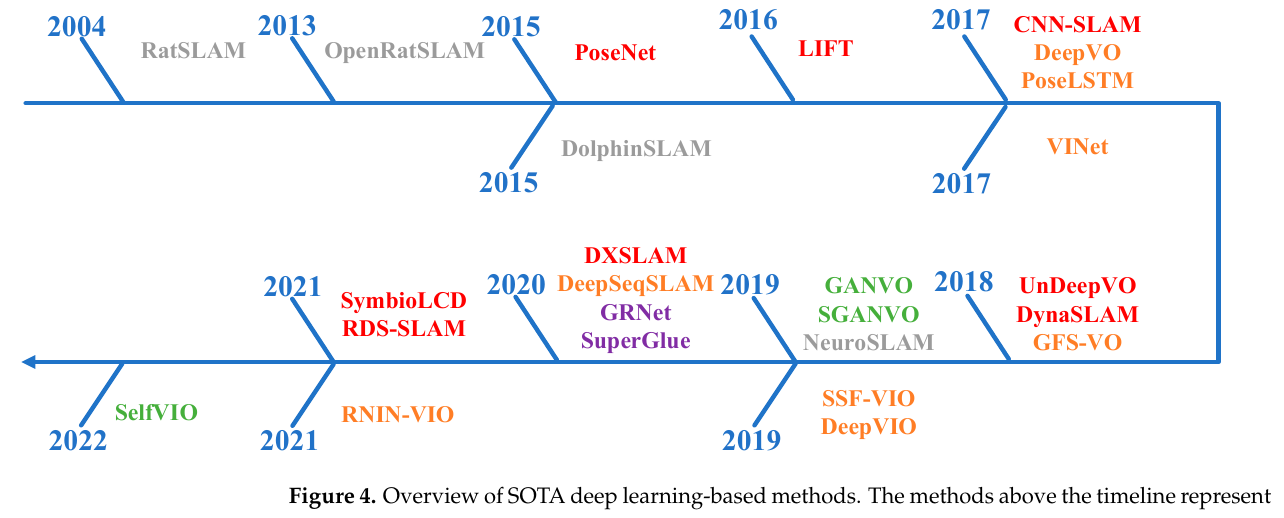
Figure 3. Pipeline of deep learning-based methods.